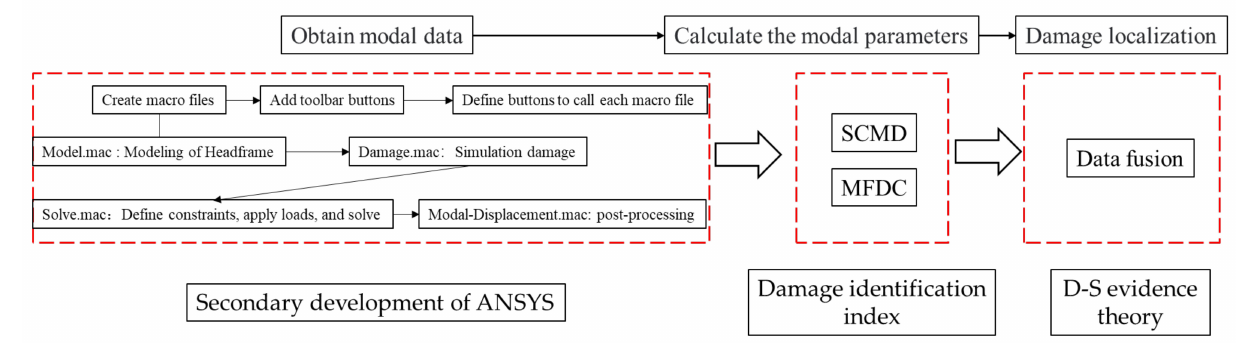
Figure 1. The process of damage